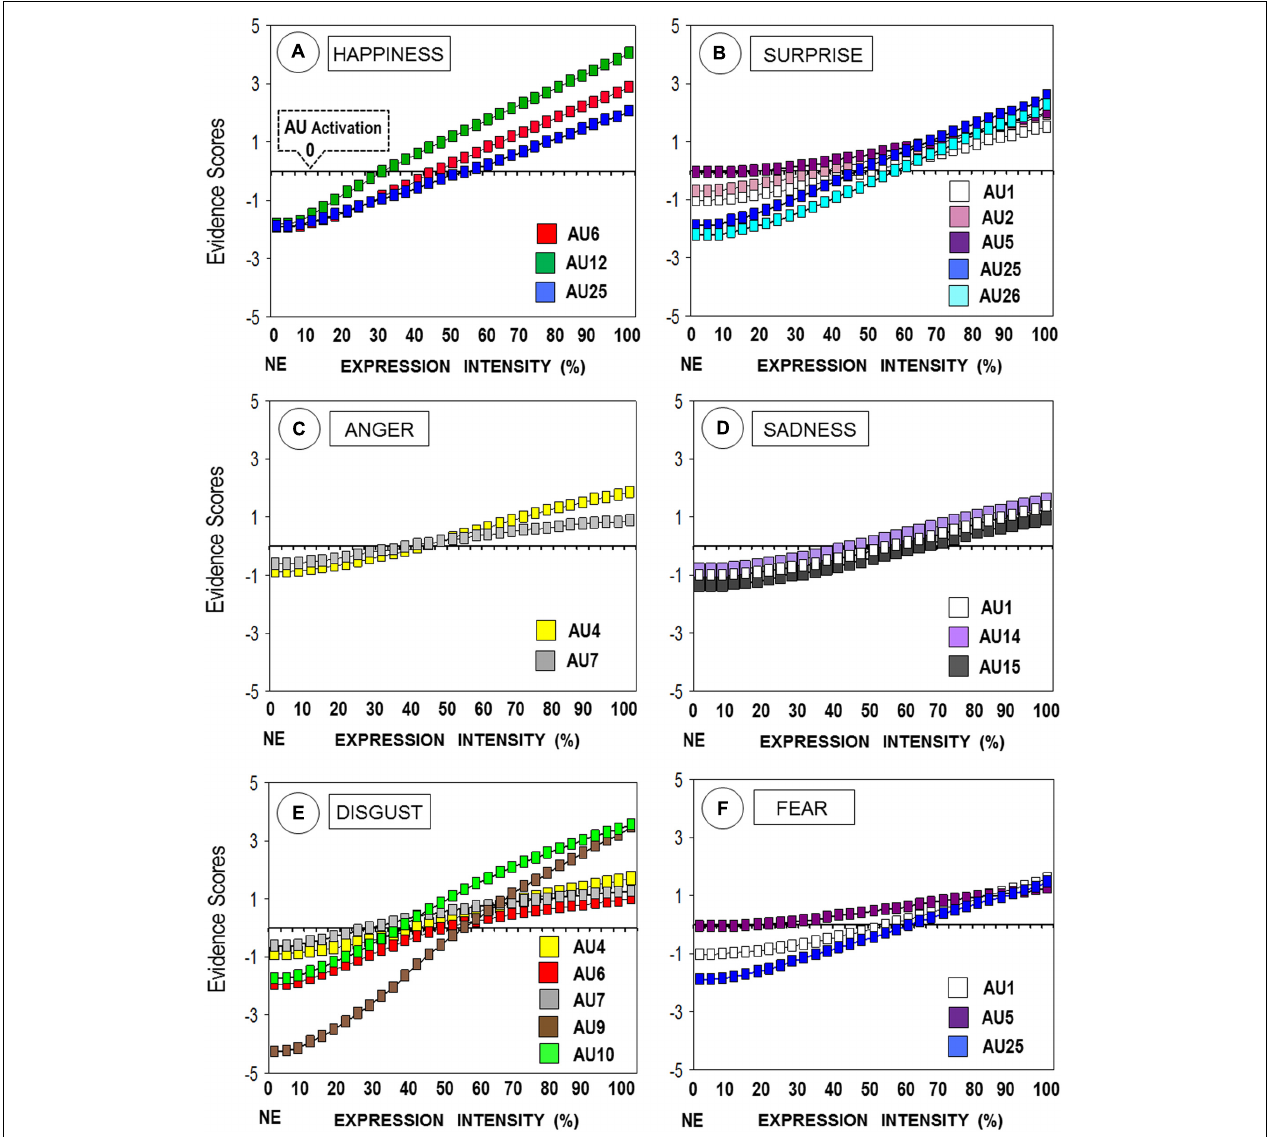
FIGURE 2 | Distribution of AU evidence scores across levels of expressive intensity. For each expression, AUs were selected if scores were higher than for the neutral face (NE, or 0% expression intensity) and were positive and above the 0 AU activation baseline. AU1: inner brow raiser; AU2: outer brow raiser; AU4: brow lowerer; AU5: upper lid raiser; AU6: cheek raiser; AU7: lid tightener; AU9: nose wrinkle; AU10: upper lip raiser; AU12: lip corner puller; AU15: lip corner depressor; AU25: lips part; AU26: jaw drop. (A) Happiness; (B) Surprise; (C) Anger; (D) Sadness; (E) Disgust; (F)